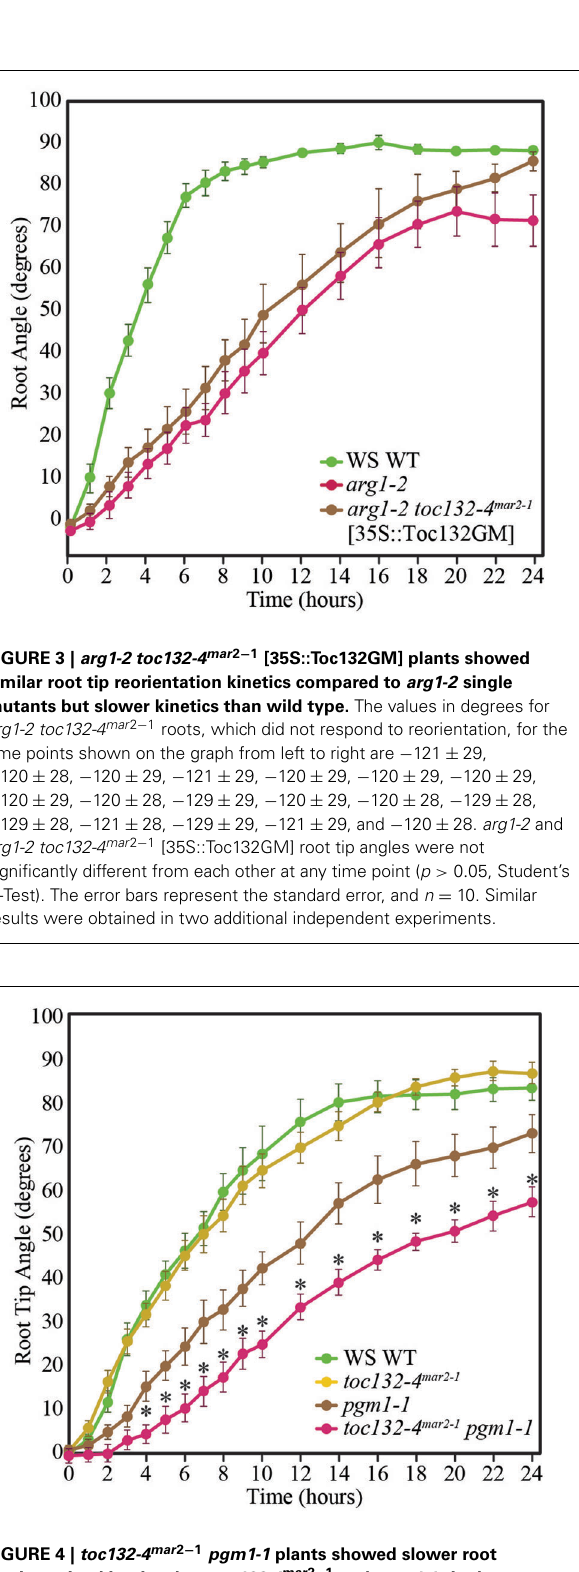
FIGURE 4 | toc132-4 mar 2 − 1 pgm1-1 plants showed slower root reorientation kinetics than toc132-4 mar 2 − 1 and pgm1-1 single mutants. The error bars represent the standard error, and n = 10. The asterisks represent significant differences between pgm1-1 toc132-4 mar 2 − 1 and the corresponding single mutants ( p < 0 . 05, Student’s T -Test). Similar results were obtained in two additional independent